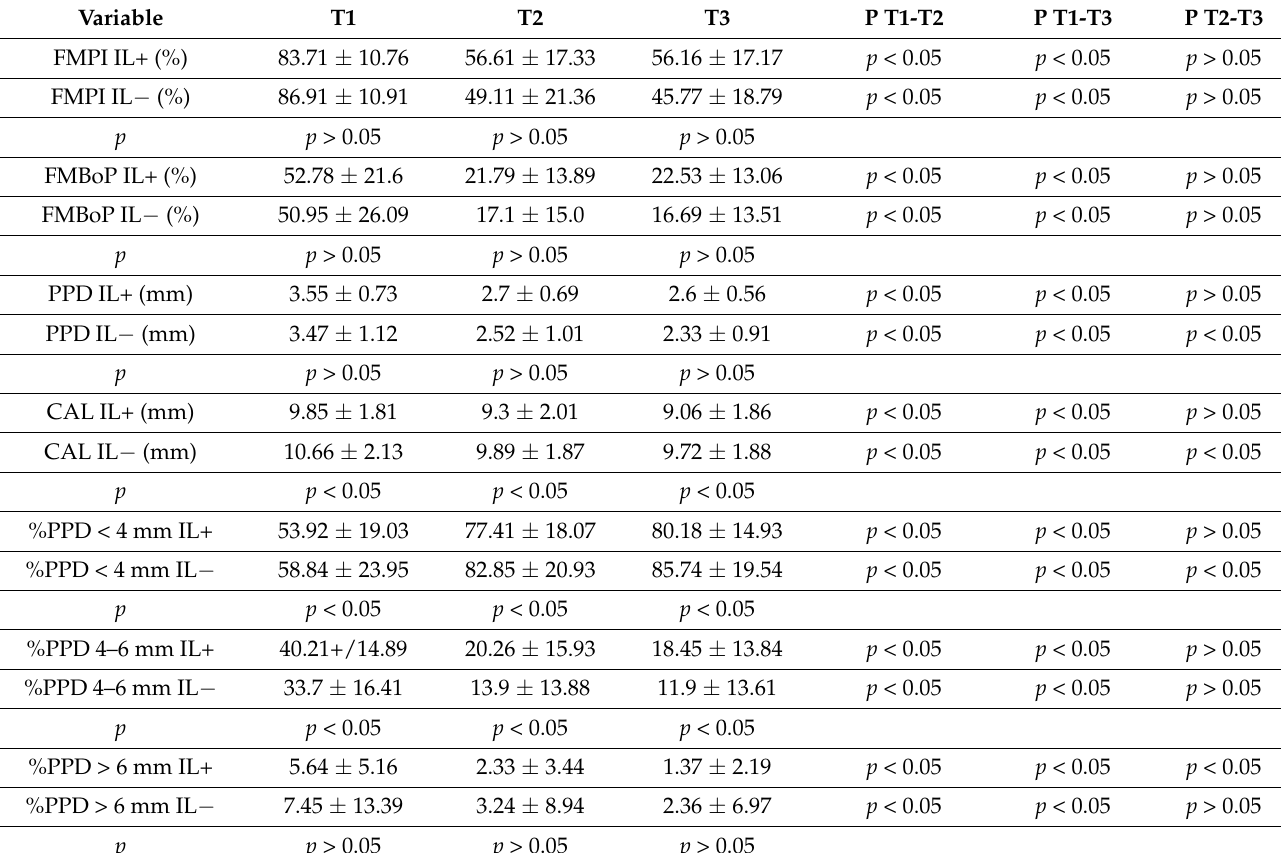
Table 2. Clinical parameters (mean and standard deviation) at baseline (T1), 6–8 weeks (T2), and 16–18 weeks (T3) after